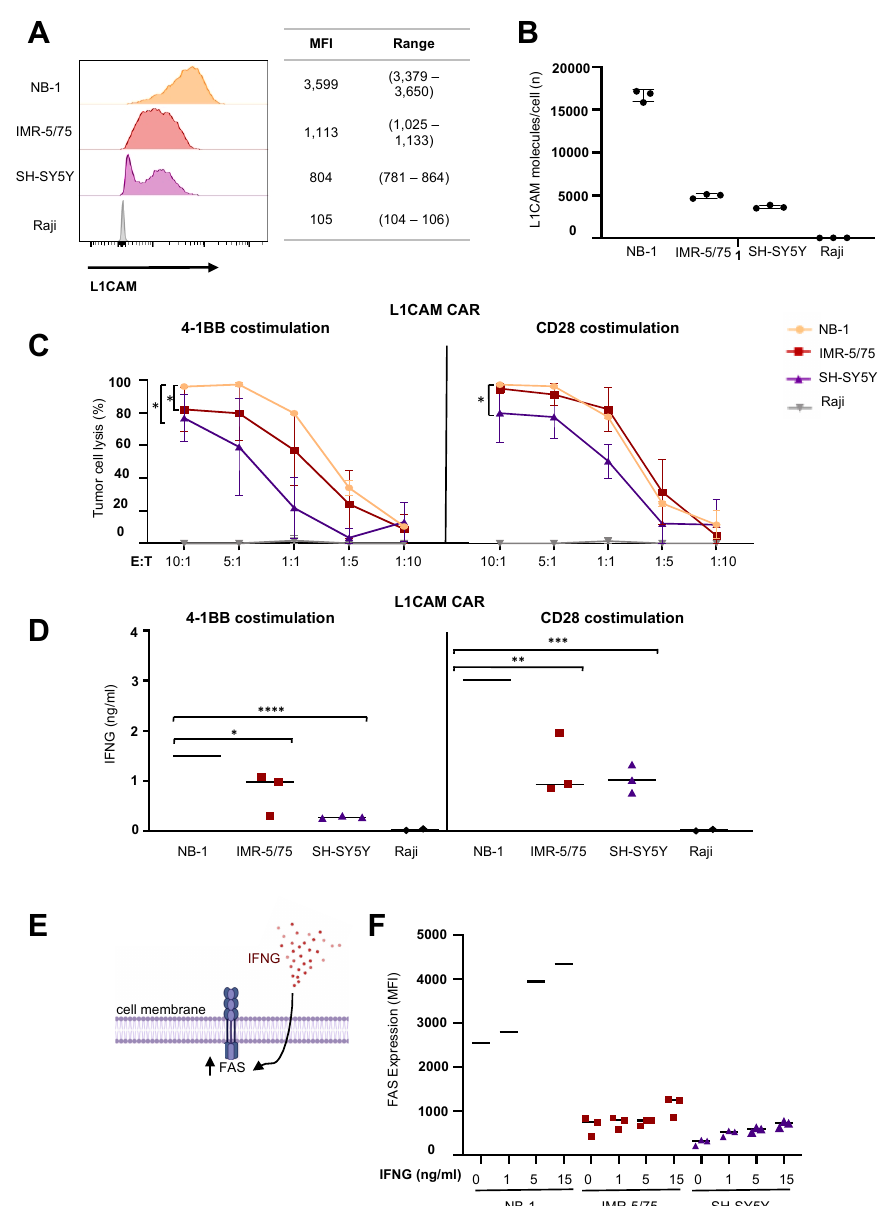
Figure 1. IFNG released by CAR T cells failed to induce FAS expression in neuroblastoma cell lines. ( A ) Target antigen expression of selected neuroblastoma cell lines measured by flow cytometry. ( B ) Target antigen density of selected neuroblastoma cells assessed by standardized QuantiBRITE calibration beads (mean ± SD, n = 3). ( C ) CAR T cell-induced tumor cell lysis after 24 h of coculture with neuroblastoma cell lines in different E:T ratios followed by luciferase-based quantification of viable cells (mean ± SD, n = 3). ( D ) IFNG release by CAR T cells after 24 h of coculture with neuroblastoma cell lines at an effector:target of 5:1 (mean ± SD, n = 3). ( E ) Illustration of IFNG- mediated FAS regulation in tumor cells. ( F ) Flow cytometrically determined FAS expression in neuroblastoma cell lines after IFNG treatment for 24 h (mean ± SD, n = 3). * p ≤ 0.05, ** p ≤ 0.01, *** p ≤ 0.001, **** p ≤